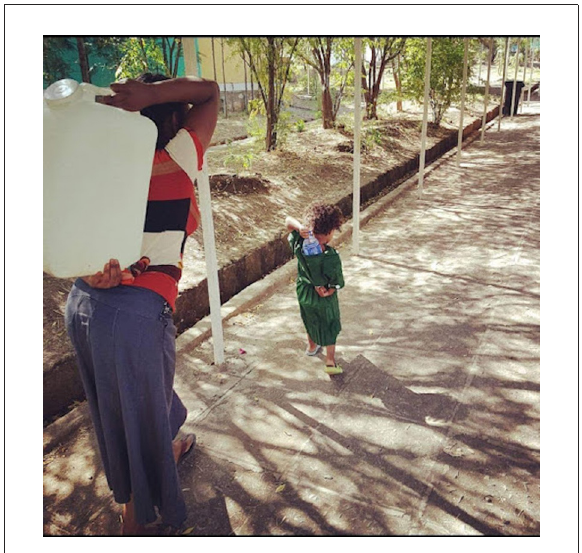
FIGURE1 Little girl helping her mother fetch water showing the gender stereotyping in the community (March 8/2017, Ethiopia).